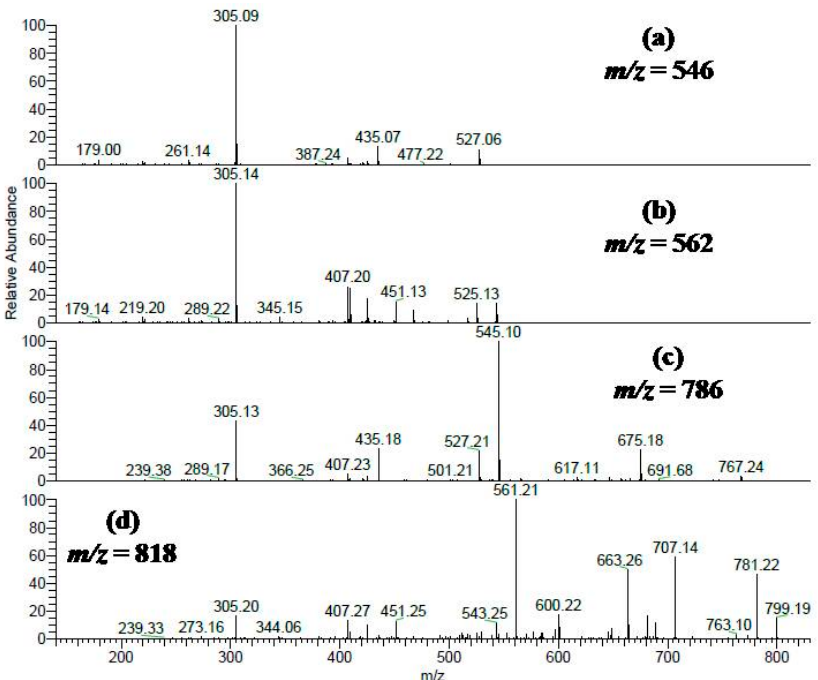
Figure 2. MS 2 fragmentation pattern of selected polyphenols from compounds listed in Table 1. ( a ) MS/MS spectrum of deprotonated compounds 22 and 23 at m / z 545; ( b ) MS/MS spectrum of deprotonated compounds 13 , 15 , 16 , and 18 at m/z 561; ( c ) MS/MS spectrum of deprotonated compounds 31 , 34 , and 35 at m/z 785; ( d ) MS/MS spectrum of deprotonated compound 26 at m / z 817.